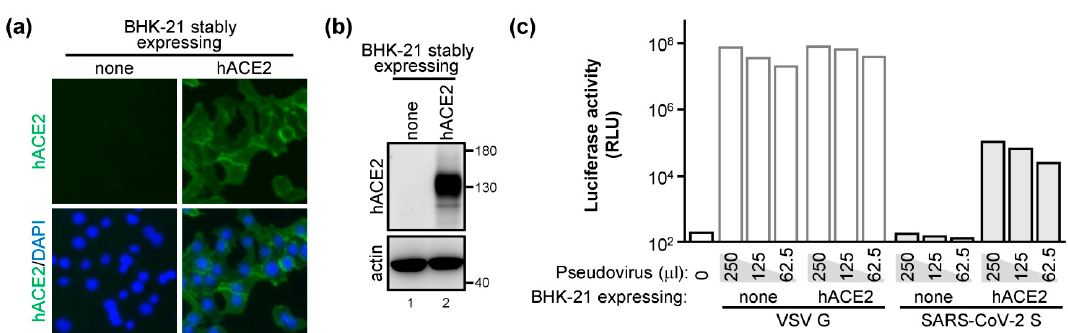
Figure 3. SARS-CoV-2 S-pseudotyped virus infects the BHK-hACE2 cells: ( a , b ) BHK-21 cells stably expressing hACE2 were fixed without permeabilization and then analyzed by immunofluorescence assay (IFA) ( a ) or were analyzed by WB ( b ) with the indicated antibodies. ( c ) Parental or hACE2-expressing BHK-21 cells were infected with FLuc reporter-carrying viruses pseudotyped with the VSV G or SARS-CoV-2 S protein as indicated. The luciferase activity was measured at 48 h post-infection and represented as the infectivity. RLU, relative light unit.